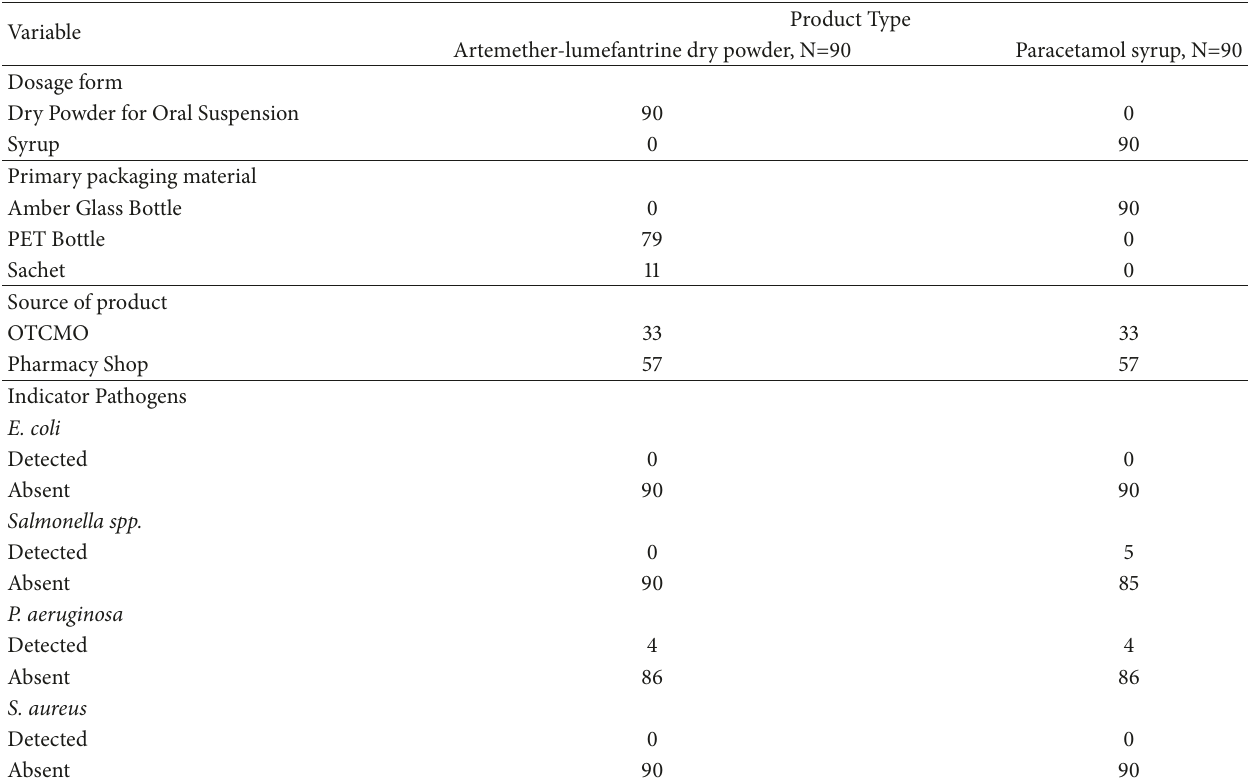
Table 1: Proportion of products stratified by dosage forms, packaging materials, sources, and